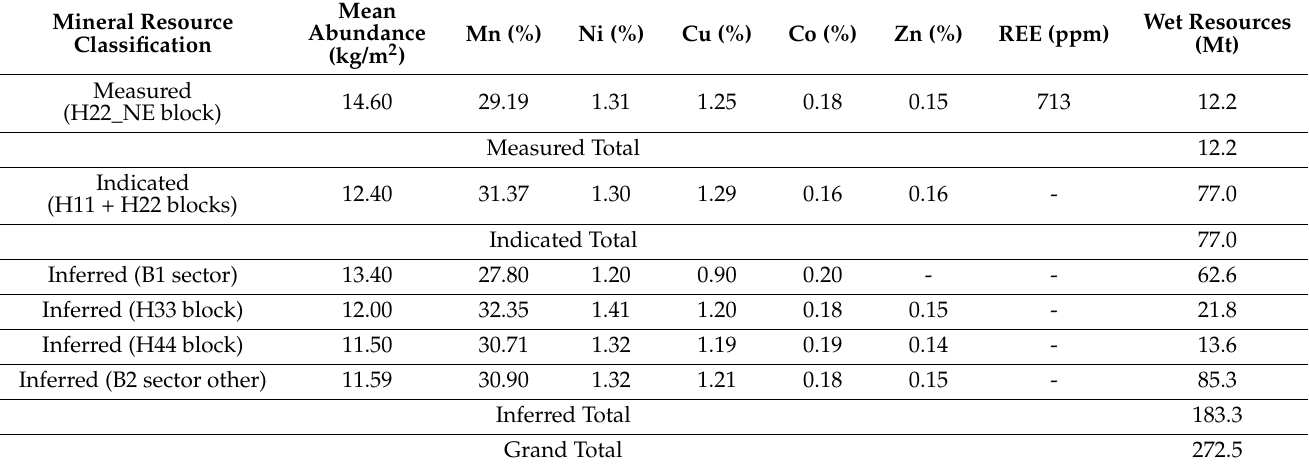
Table 1. Mineral resource estimate of wet polymetallic nodules in the B1 and B2 sectors of the IOM exploration area. Cutoff 10 kg/m 2 of wet nodules—without volcanoes, seabed areas free of nodules, and areas sloped over 7, as per Mucha et al. [23], Szamałek